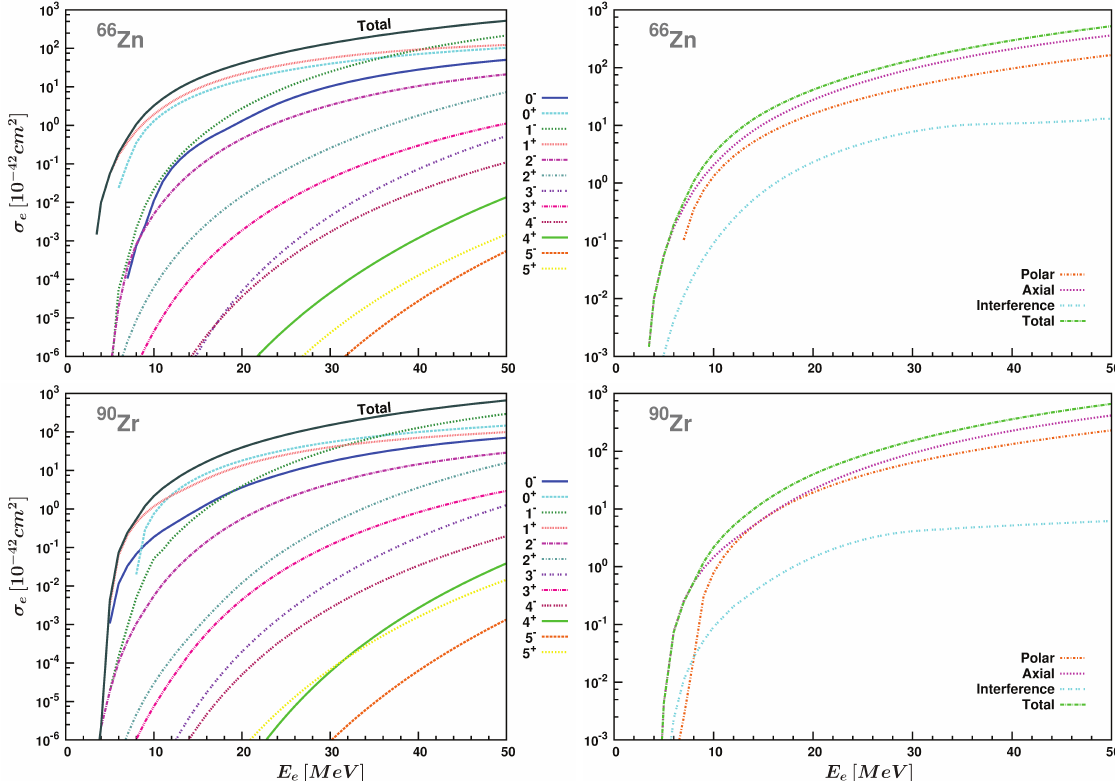
Figure 7. The same as Figure 5 but for 66 Zn ( e − , ν e ) 66 Cu and 90 Zr ( e − , ν e ) 90 Y